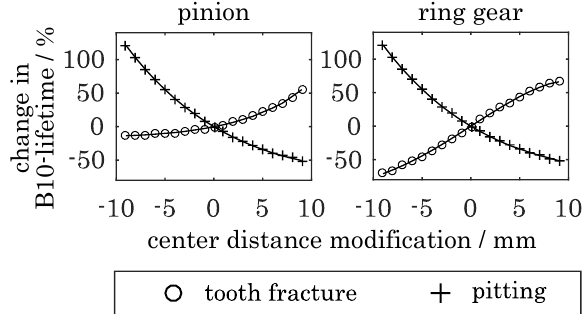
Figure 10: B 10-lifetime changes for center distance modification, Load: 30 t, Wind speed: Beaufort